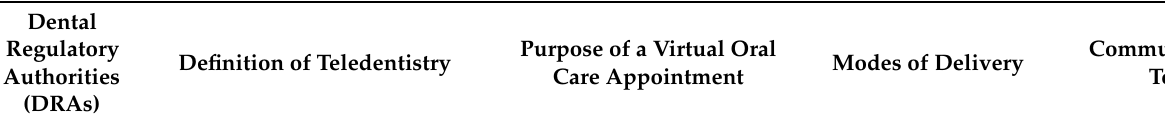
Table 3. Definition and Applications of